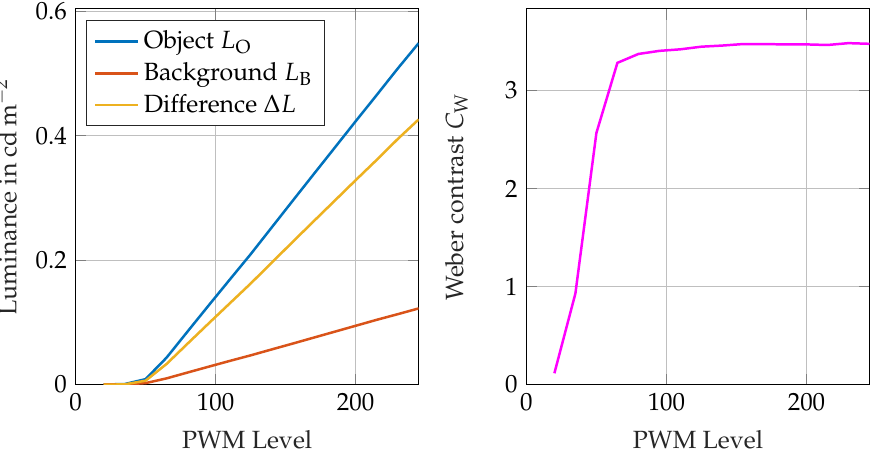
Figure 8. Luminances L ( left ) and Weber contrast C W ( right ) of the gray card at object position 1 in the light tunnel; due to the linear increase in the luminance difference ∆ L and the background luminance L B , the contrast gradient enters saturation.